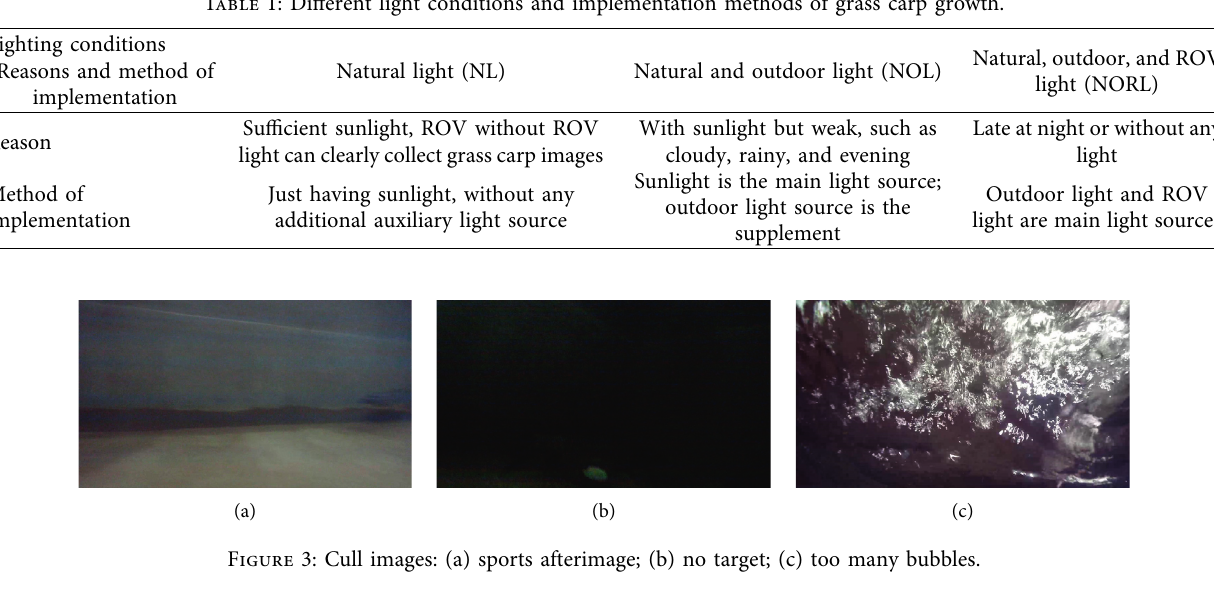
Figure 2: The sample content of the dataset: (a) robot fish; (b) grass carp. Table 1: Different light conditions and implementation methods of grass carp growth.